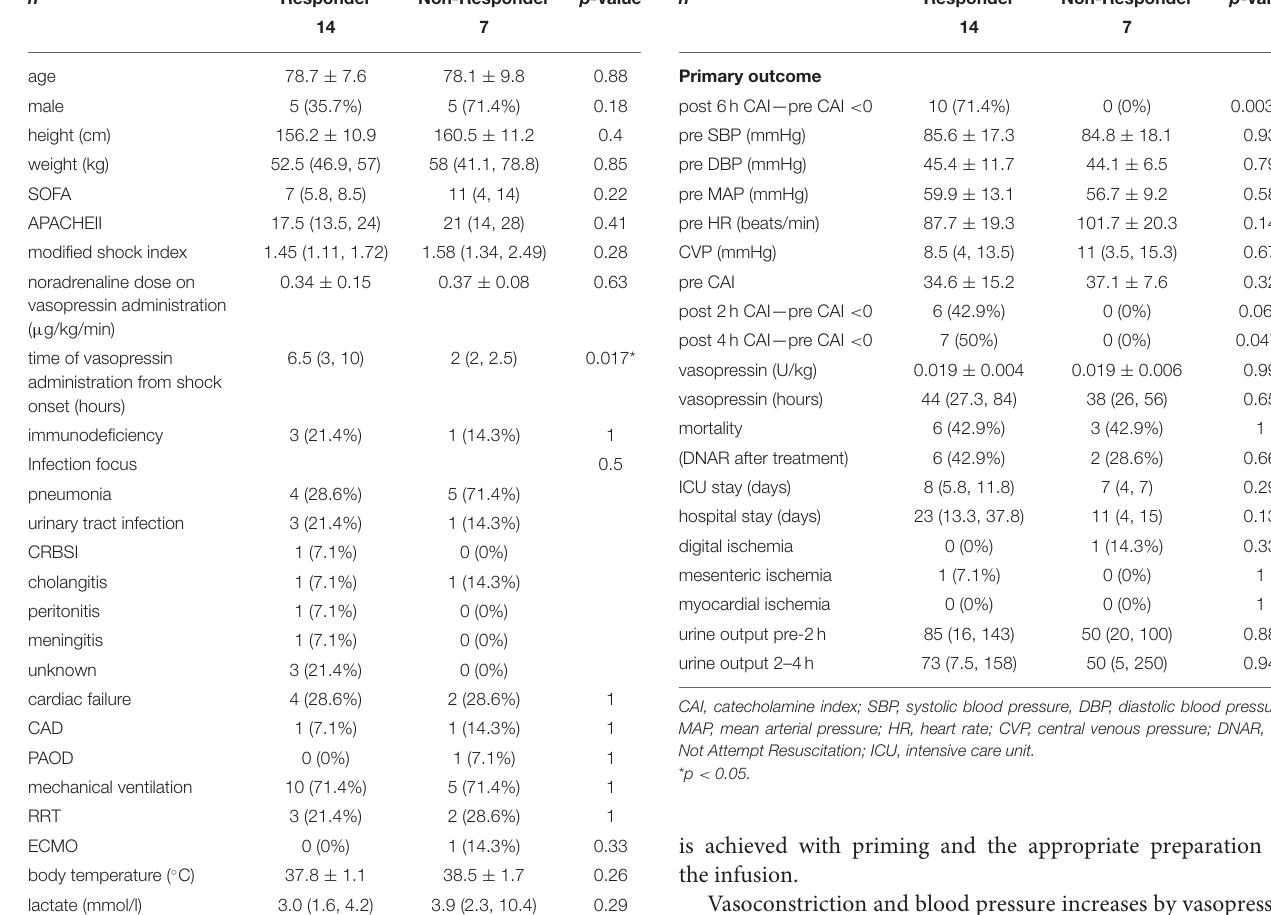
TABLE 2 | Outcome differences between vasopressin loading responders and non-responders.